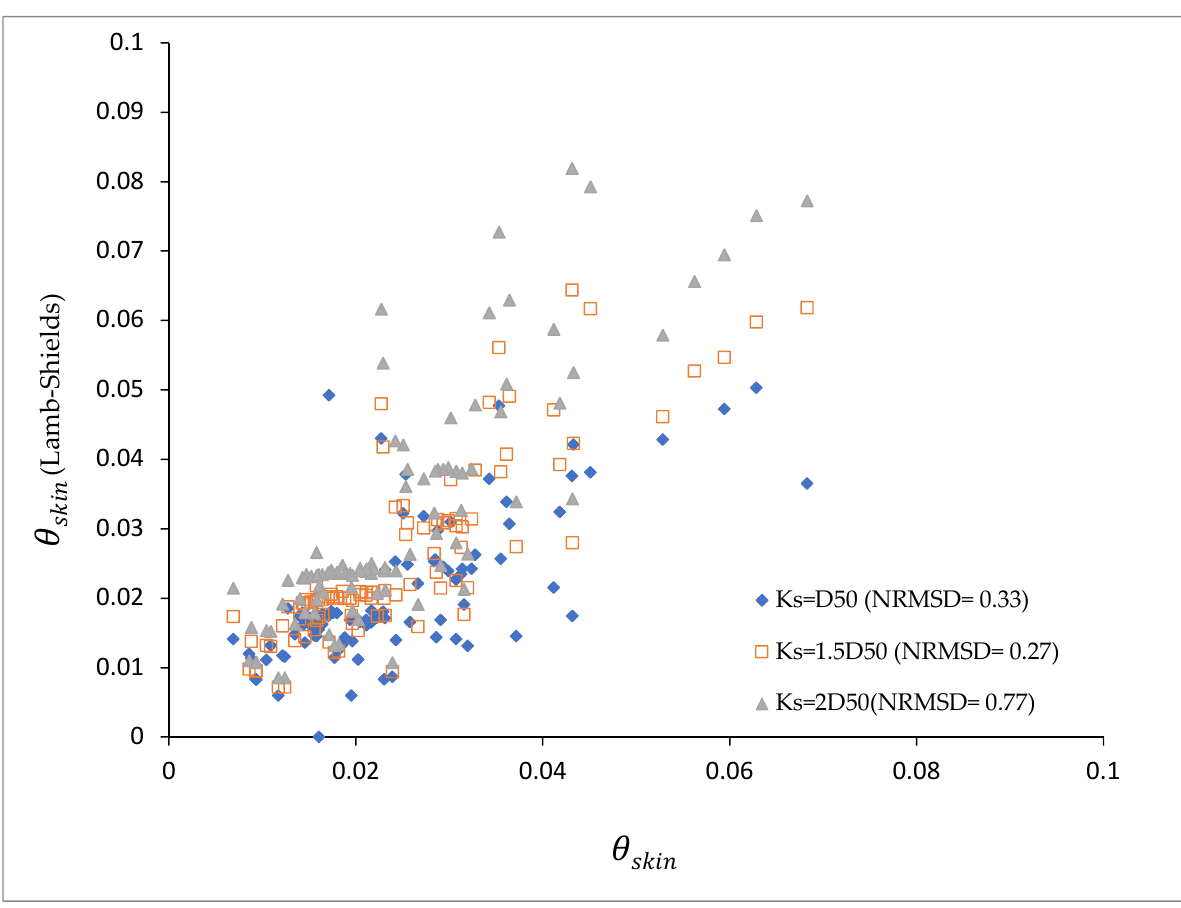
Figure 3. Comparison between values of modified momentum thickness of skin friction and their correlation with the Keulegan–Shields approach.